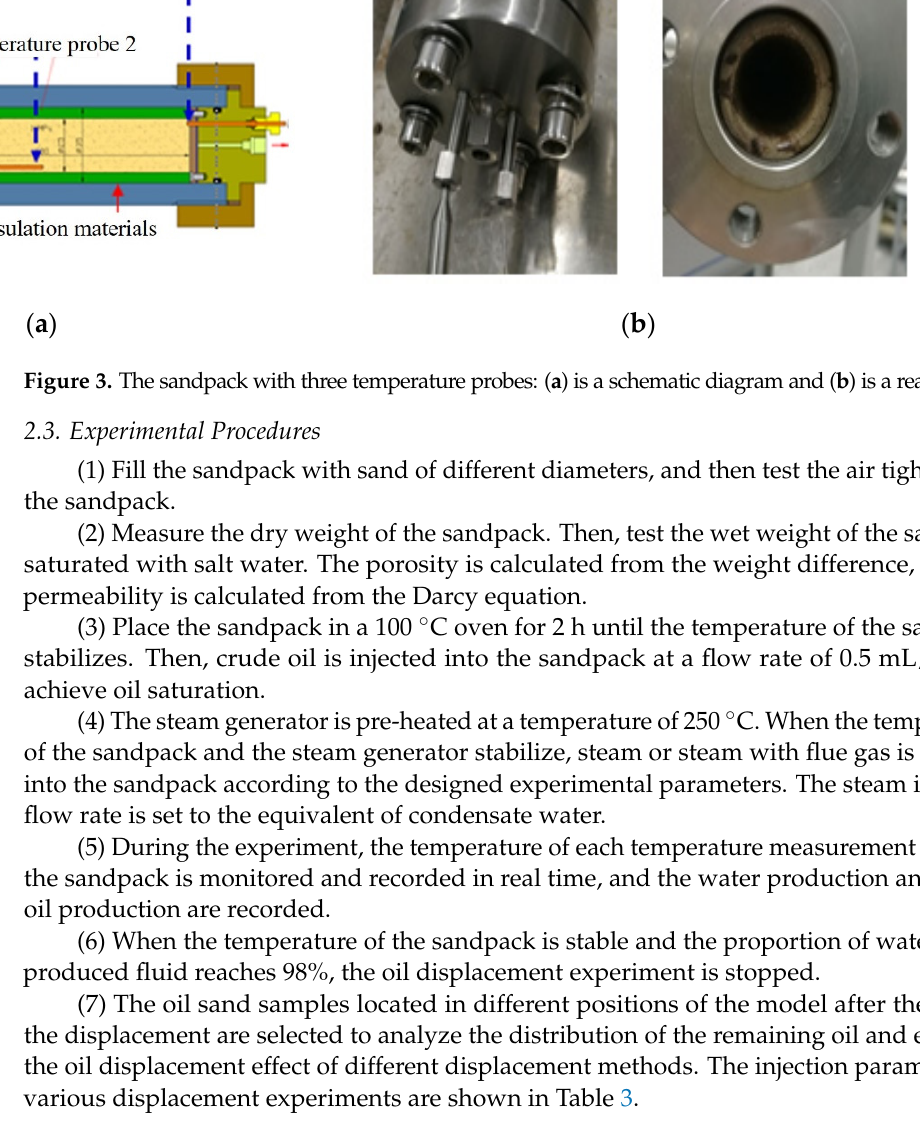
Table 3. Injection parameters of various displacement